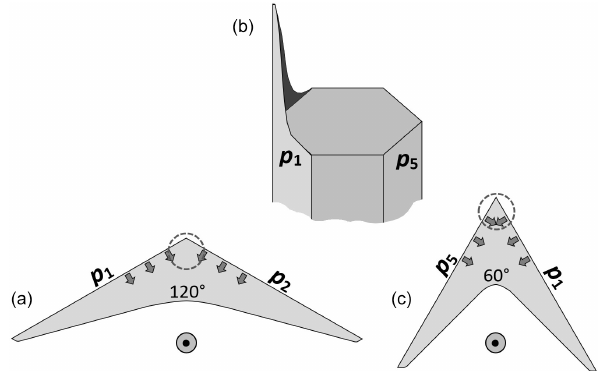
Figure B9. Needle-tip cross sections. Prism face p 1 through p 6 run clockwise around crystal sketch in (b) . Bottom sketches show views looking straight down needle axis: ( a ): case from sheath with prisms p 1 and p 2 ; ( c ): case from sheath initially with prisms p 1 , p 6 , and p 5 , but middle prism p 6 vanished. Arrows show AST flux from adjoining prism faces.